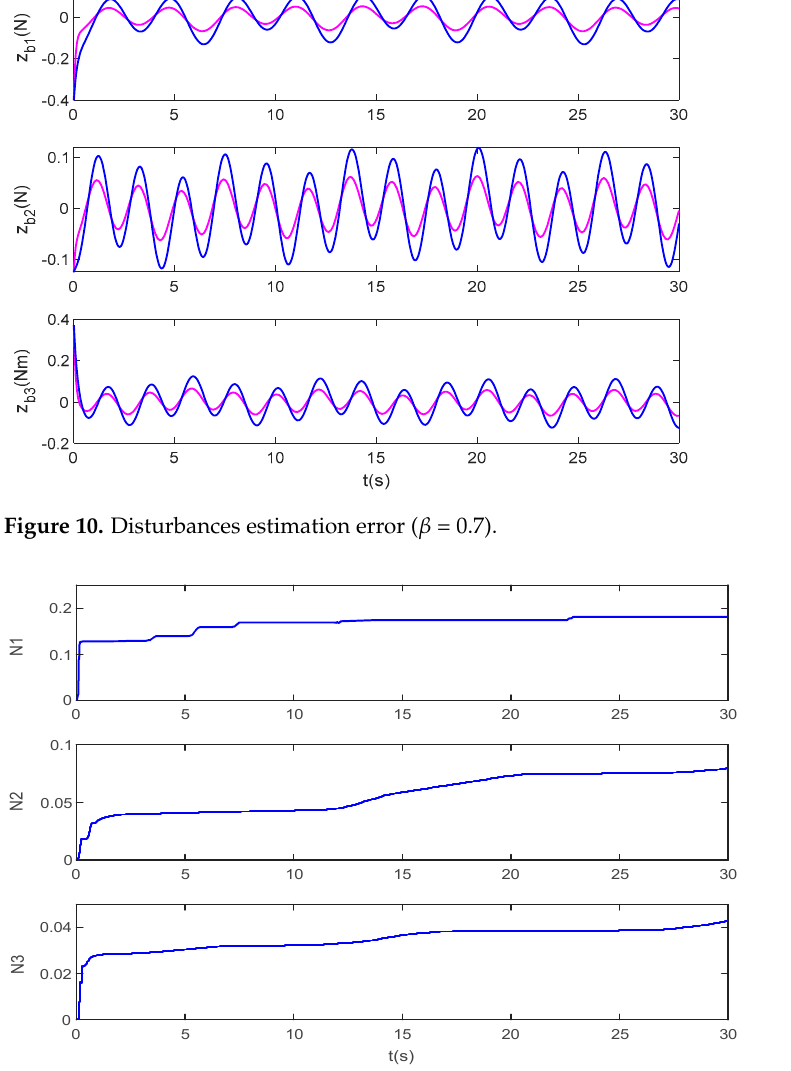
Figure 11. Nussbuam parameters change curves.